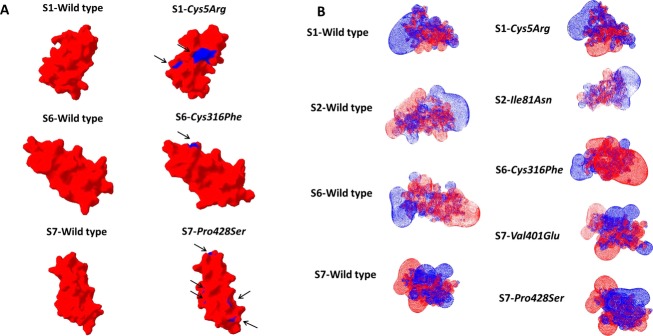
Surface electrostatic potential and Hydrophobic patch representations of Sushi domains. (A) Surface electrostatic potential map for the simulation averaged structures of wild-type sushi domains alongside the simulation-averaged structures of their corresponding mutated sushi domains. The images have been generated on SWISS-PDB viewer. The surface electrostatic potential calculations were made using the Poisson-Boltzmann method utilizing partial charges of atoms. The default dielectric constant of four for the protein and 80 for the solvent were used during calculations. An ionic strength of 50 mmol/L was used during calculations. Red color denotes negative potential while blue denotes positive potential. (B) Hydrophobic patches as determined with the SWISS-PDB viewer tool for simulation averaged structures of wild-type and mutated sushi domains. Surface representations of the sushi domains are shown. Hydrophobic patches are colored blue while the rest of the domain is colored red. The combined calculated areas of all hydrophobic patches for each sushi domain (in those detected) have been tabulated in Table S2.